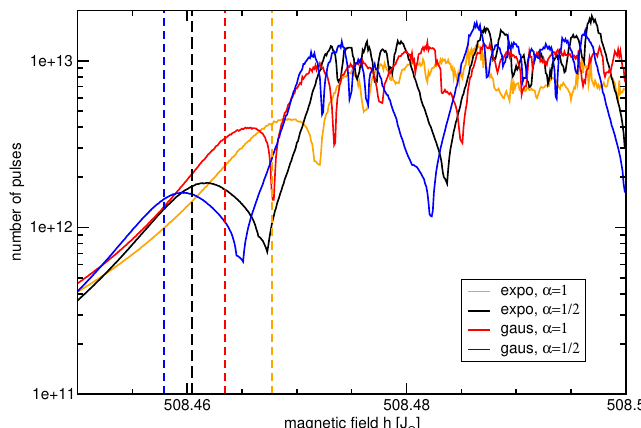
= 0.01) for N = 5, thresh